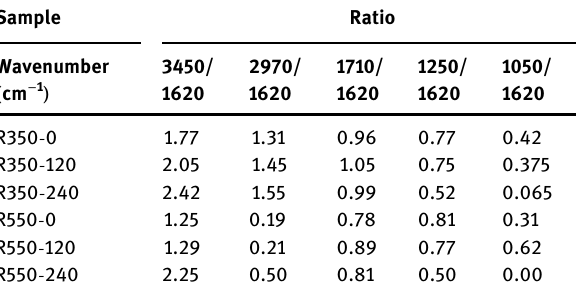
Table 3: Ratios of the main characteristic DRIFTS